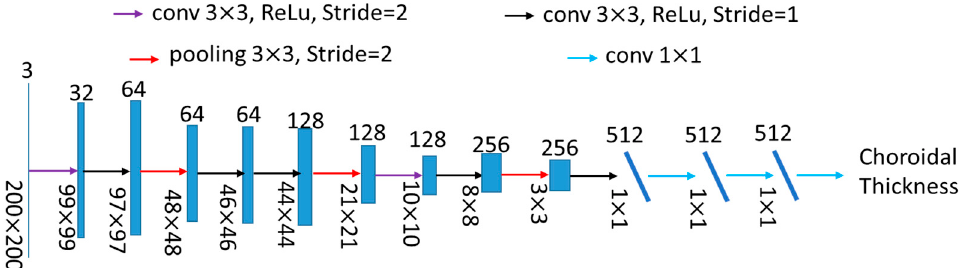
Figure 3. The network architecture applied in this work.